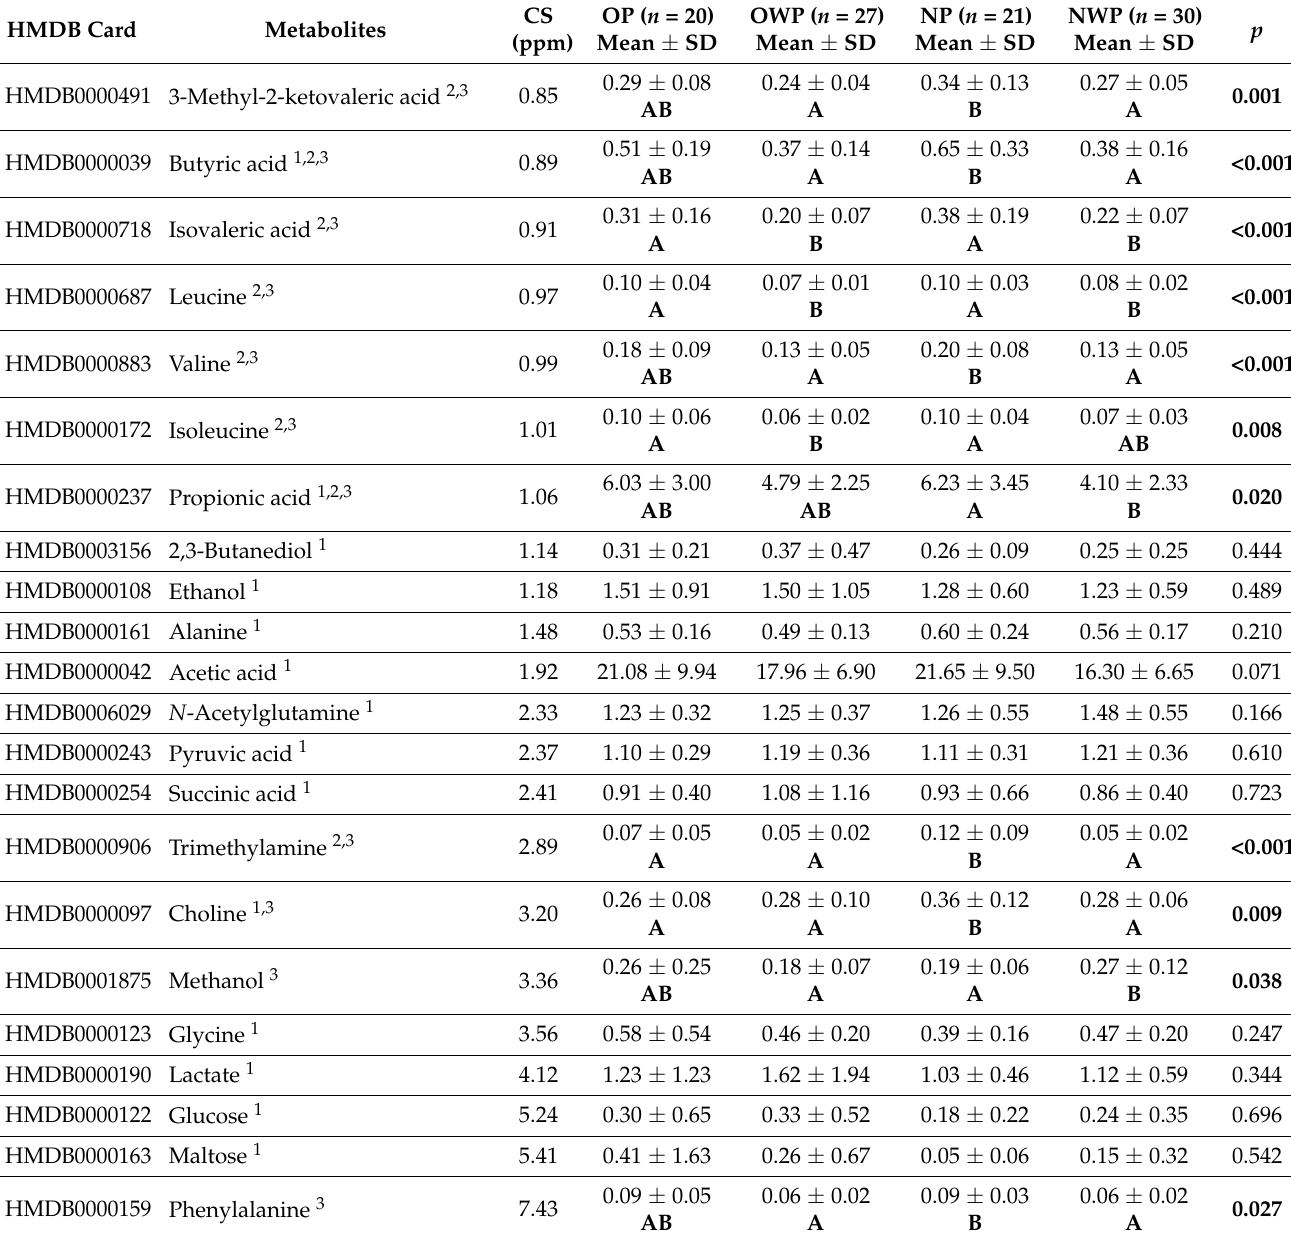
Table 3. Main saliva metabolite concentration shown as the mean, standard deviation, chemical shift (ppm), and statistical analysis from multivariate analysis using the (1) VIP scores, (2) loading factor, and (3) univariate